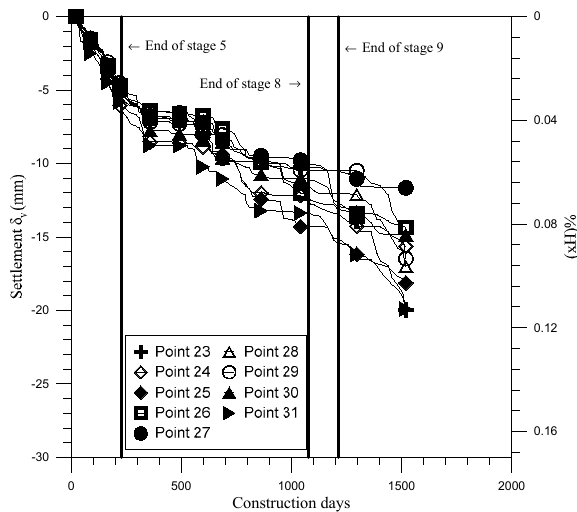
Figure 9. Settlement of points 23–31 of wall. Table 2. Comparison of settlement of top of retaining wall at final excavation and backfilling.